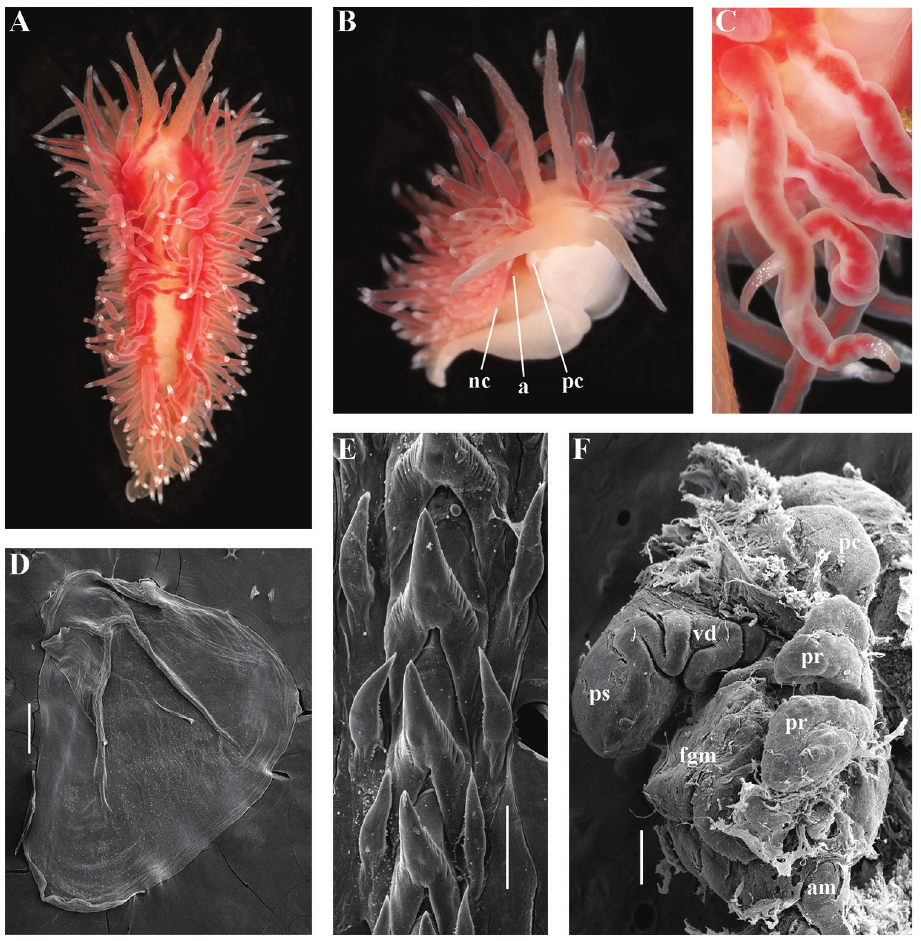
Figure 6. Chlamylla intermedia (Bergh, 1899). ZMMU Op-481. Laptev Sea, living specimen 15 mm in length: A dorsal view B latero-ventral view C details of cerata D jaw, SEM E radular teeth, posterior part, SEM F reproductive system, SEM. Abbreviations: a anus am ampulla fgm female gland mass nc con- tinuous notal edge pc penial collar (external) pr prostate ps penial sheath vd vas deferens (muscular part). Scale bars: D = 300 μm; E = 100 μm; F = 300 μm. Photos of living specimens by O.L. Zimina, SEM images by A.V.